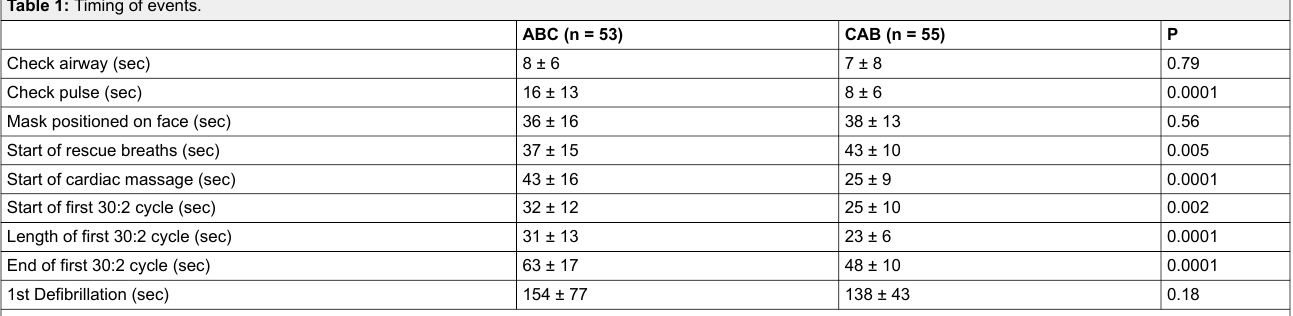
Table 1: Timing of